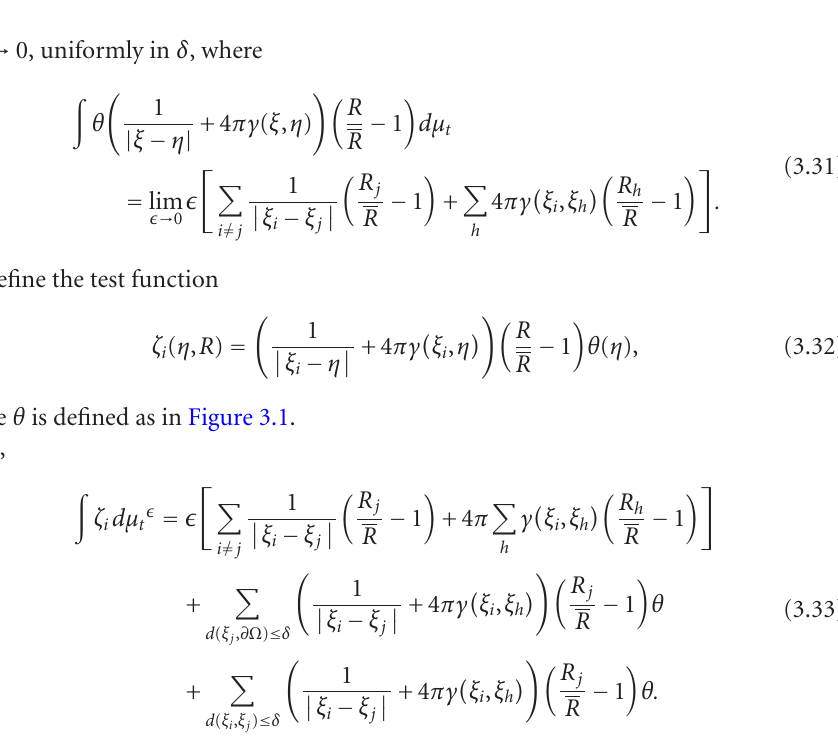
Figure 3.1. Graph of the function θ ( η